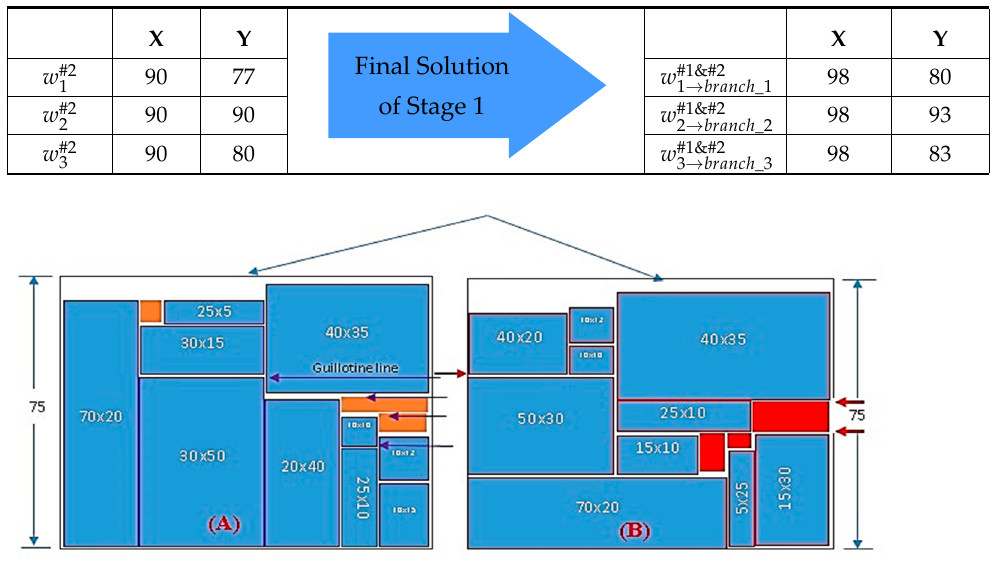
Figure 12. Proposed solution for two